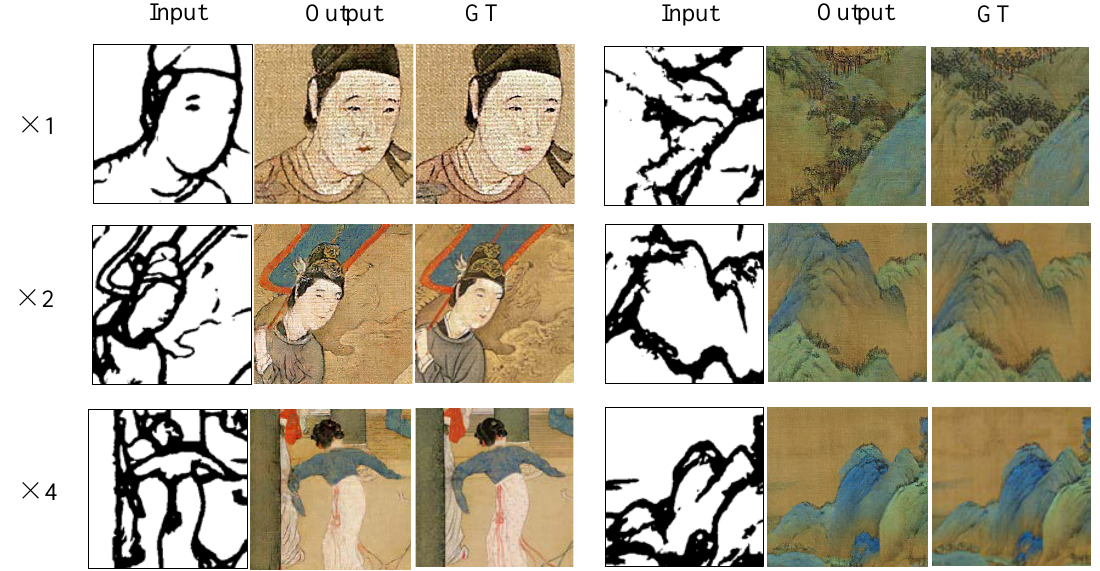
Figure 8. Multi-scale input and its corresponding output. We reduce the original image to 1/2 and 1/4 of the original size by bilinear interpolation to generate multiscale images. ( Top ) The small level scale input sketch; ( middle ) the middle-level scale input sketch; ( bottom ) the large level scale input